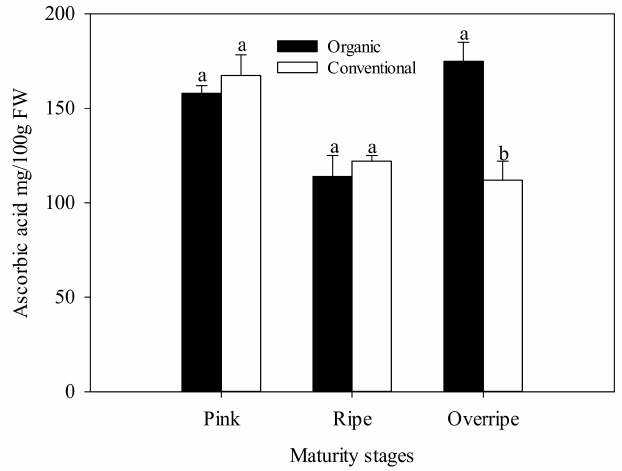
Figure 1. Ascorbic acid in three stages of maturity with two fertilization procedures. The results are represented as means ± standard deviation. Different letters between maturity stages indicate statistical difference at the 5% level of